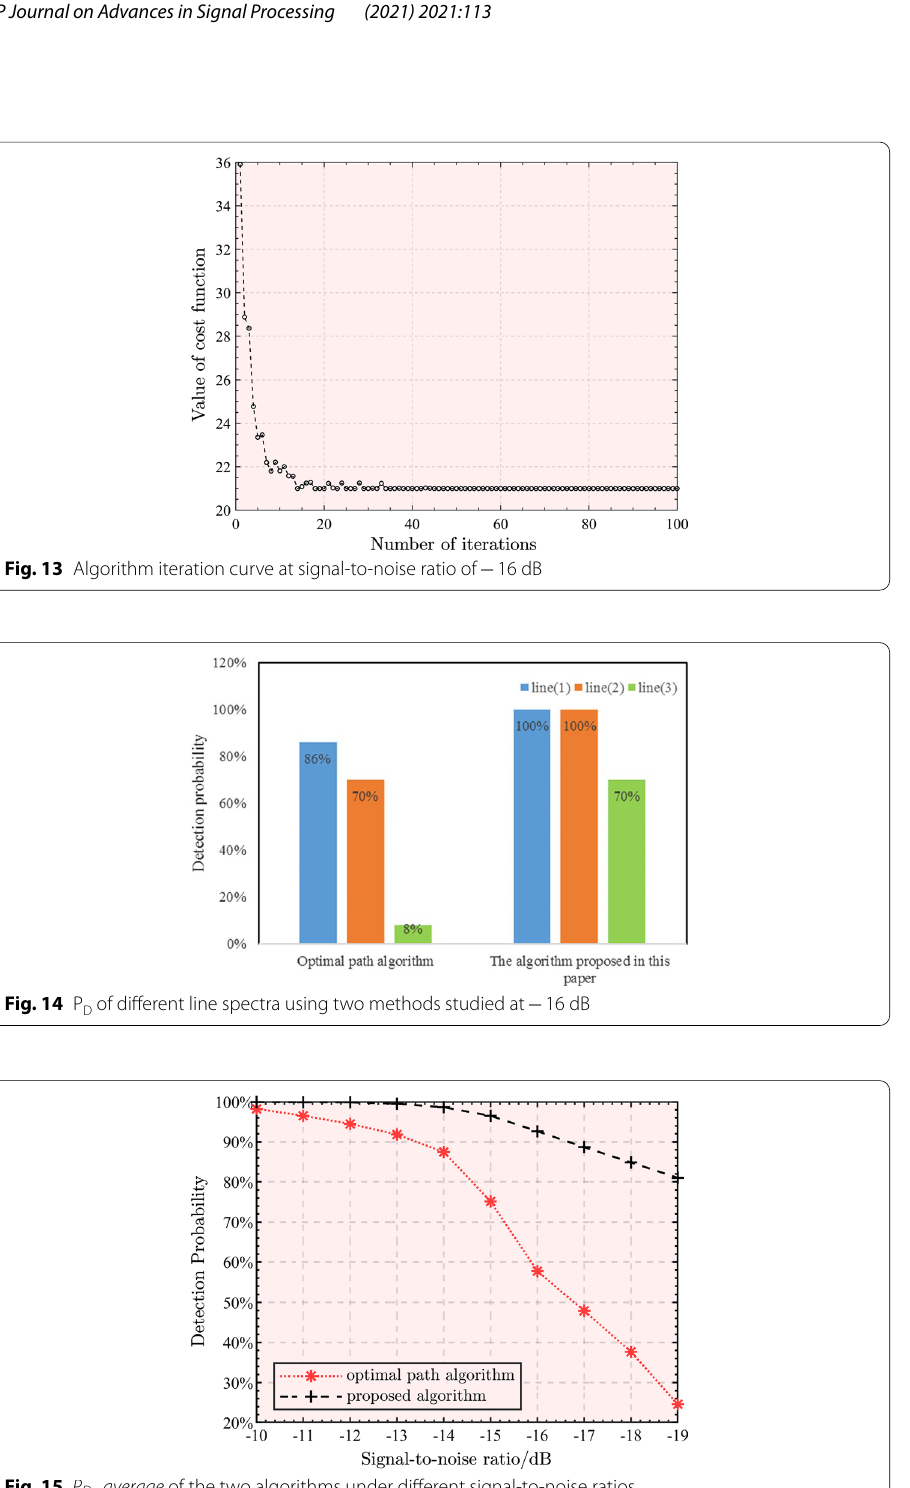
Fig. 15 P D _ average of the two algorithms under different signal-to-noise